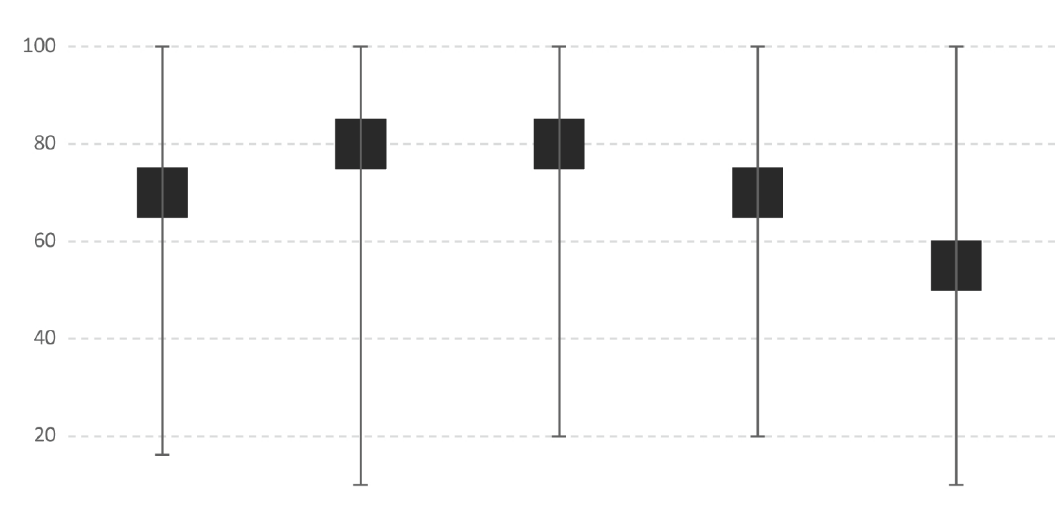
Figure 2. Ceiling or floor effects.